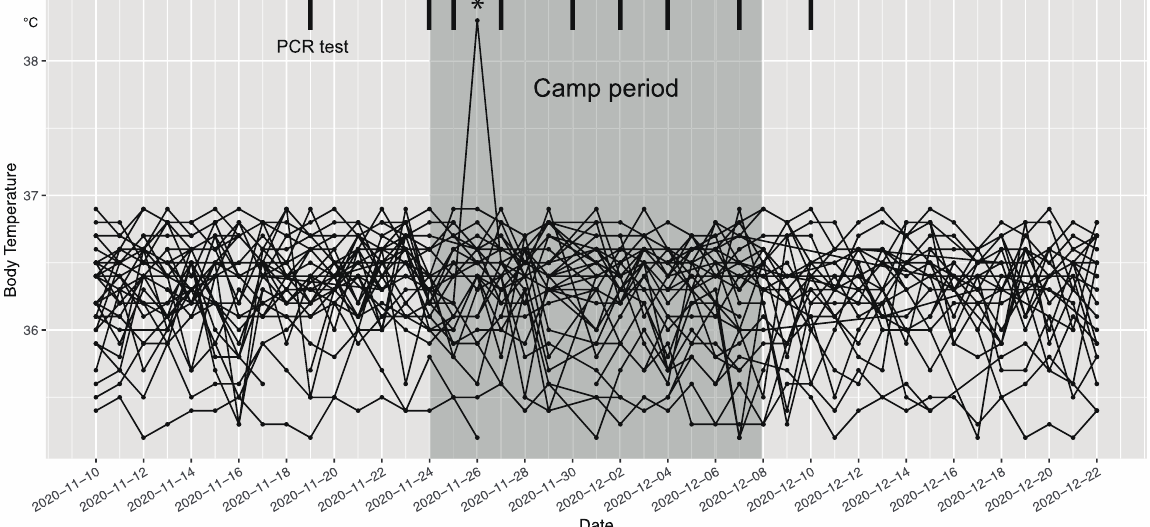
Figure 2. Body temperature chart line–scatter plot for all athletes. The darker grey shaded area is the camp period (15 days); thick vertical lines denote days on which PCR tests were performed; and the asterisk denotes the single febrile athlete recorded on day 3.